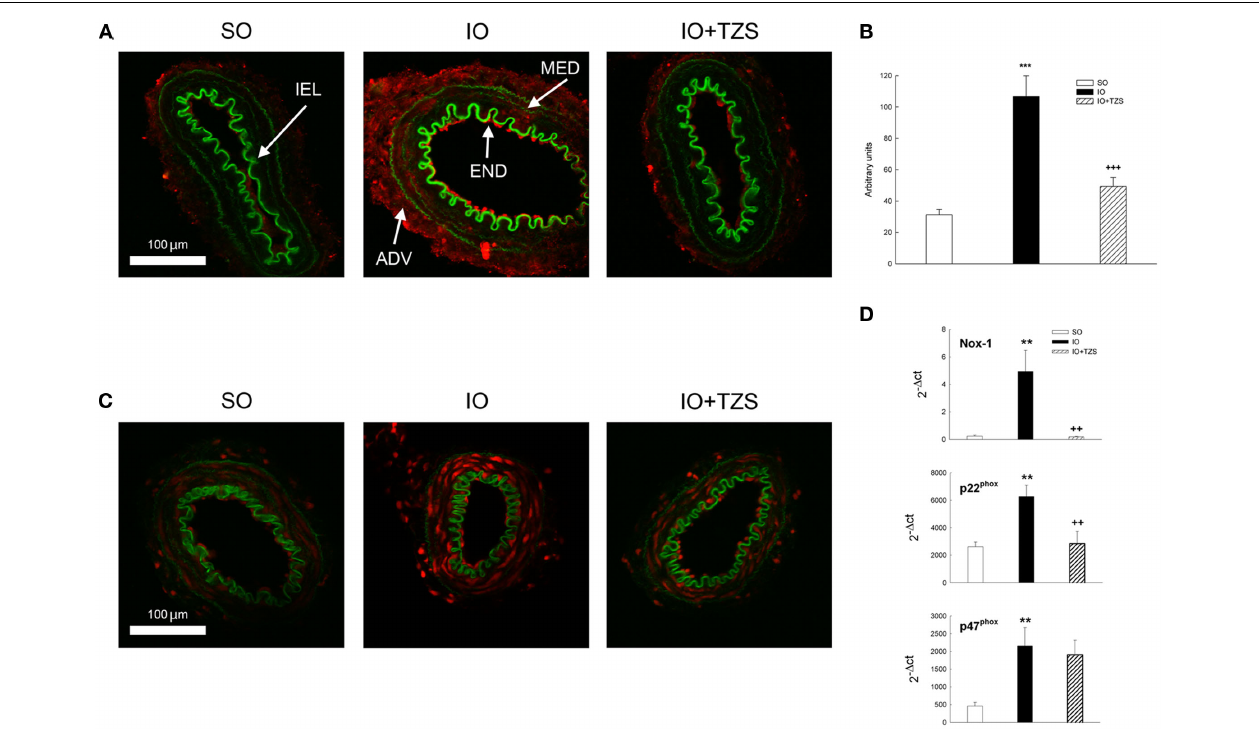
FIGURE 8 | Influence of tezosentan (TZS) treatment on (A,B) collagen I/III immunofluorescence; (C) ethidium bromide fluorescence and (D) mRNA levels of the NAD(P)H-oxidase subunit Nox-1, p22 phox , and p47 phox in mesenteric resistance arteries from IO rats. ADV, adventitial layer; END,